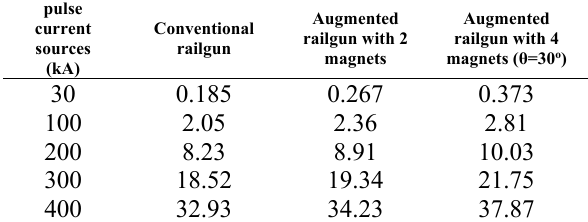
Table 1: Armature Lorentz force (kN) versus the pulse current